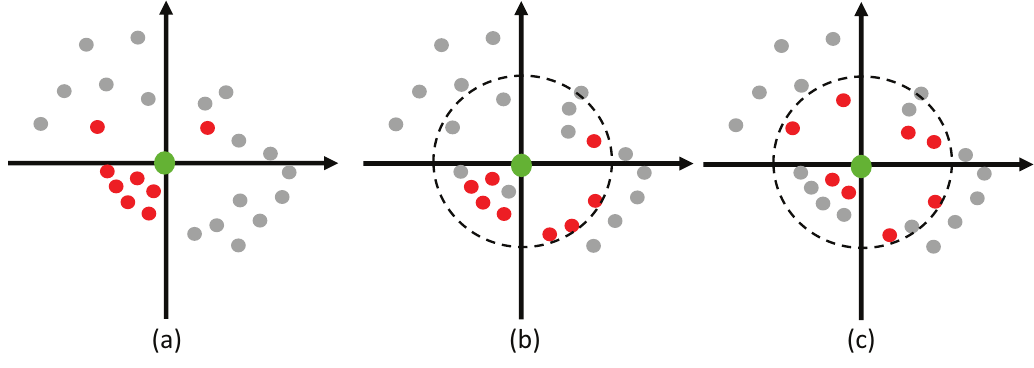
Figure 2. Illustration of the selection of neighbor points. ( a ) neighbor points selected by K nearest neighbor searching; ( b ) neighbor points selected by ball query searching; ( c ) neighbor points selected by octant-search.